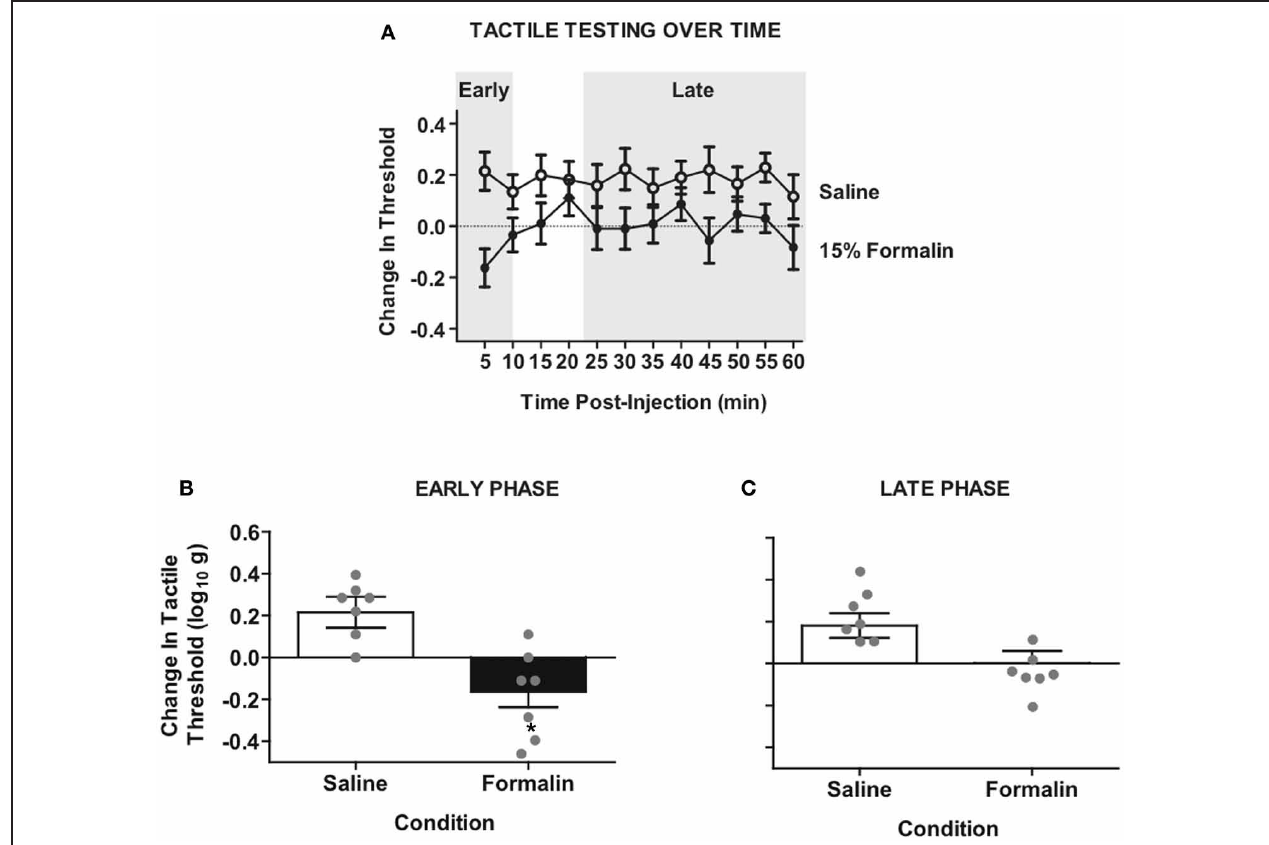
FIGURE 3 | Intradermal formalin produces ipsilateral hyper-reactivity in rats with complete SCI. (A) Time-course of hyper-reactivity with repeated von Frey testing on the plantar surface of ipsilateral hindpaw after intradermal formalin injection. Mixed factorial Three-Way ANOVA revealed significant interaction of testing side × condition, F ( 1 , 12 ) = 5 . 59, p < 0 . 05.